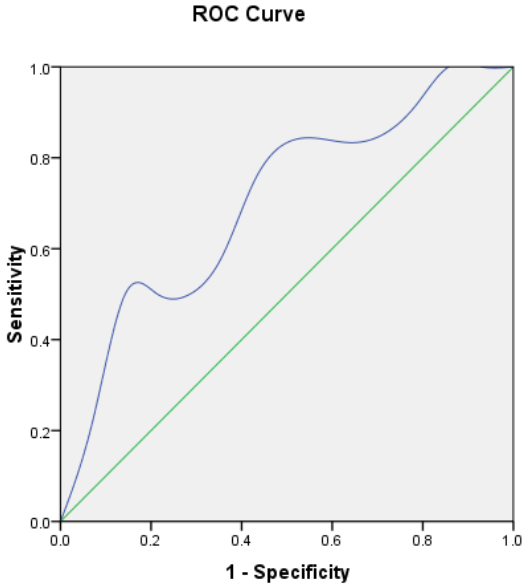
Figure 4. ROC curve calculation for Logistic regression model applied to the validation group (n =